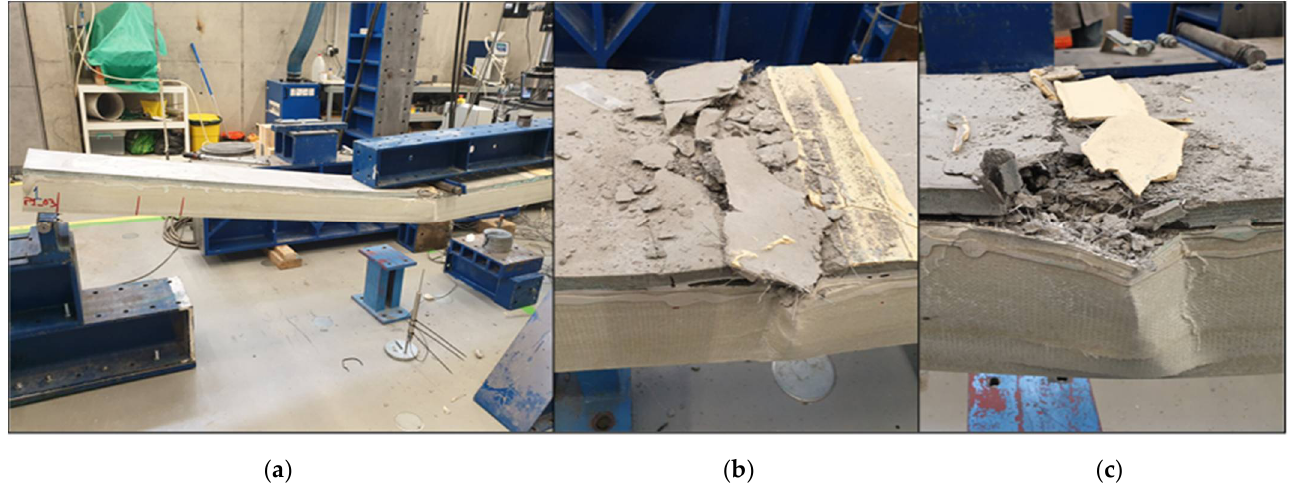
Figure 12. Photo of the failure mode—local bucking on the side webs of the GFRP profile and FRC crushing: ( a ) location of failure, ( b ) detail of failure in panel P1_F, and ( c ) detail of failure in panel P2_F.